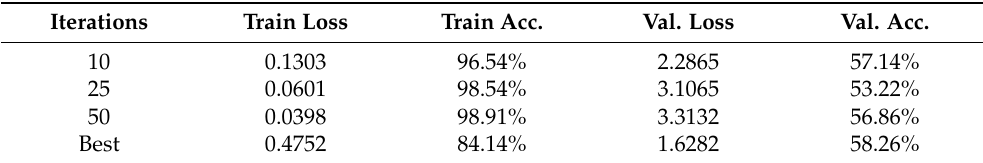
Table 9. Comparison of experimental results using typical classification methods for seven classes of Arabic